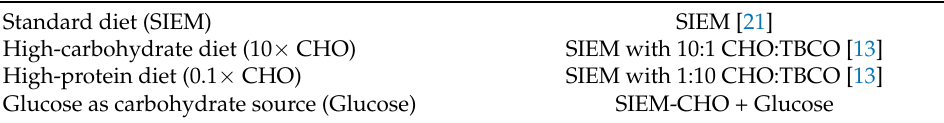
Table 1. Dietary interventions TIM-2